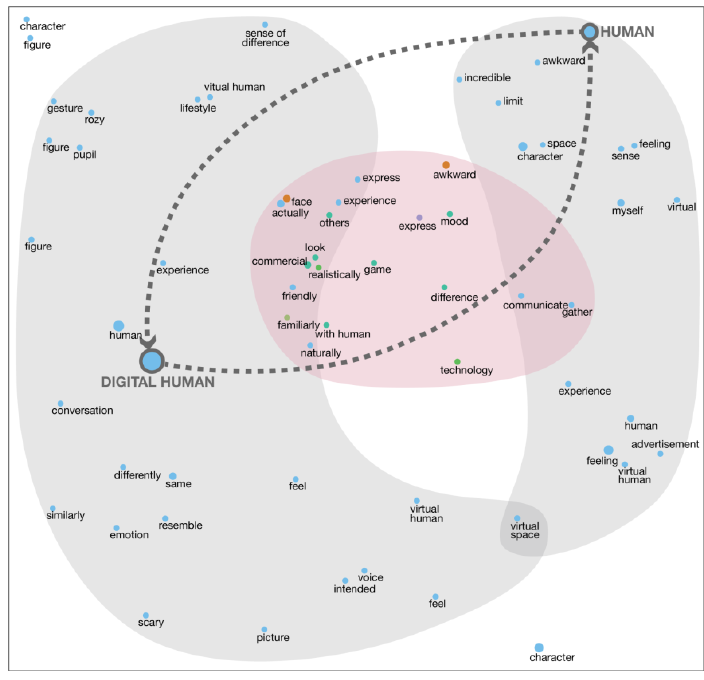
Figure 7. Two-dimensional Cluster Map for Digital Humans and Humans.